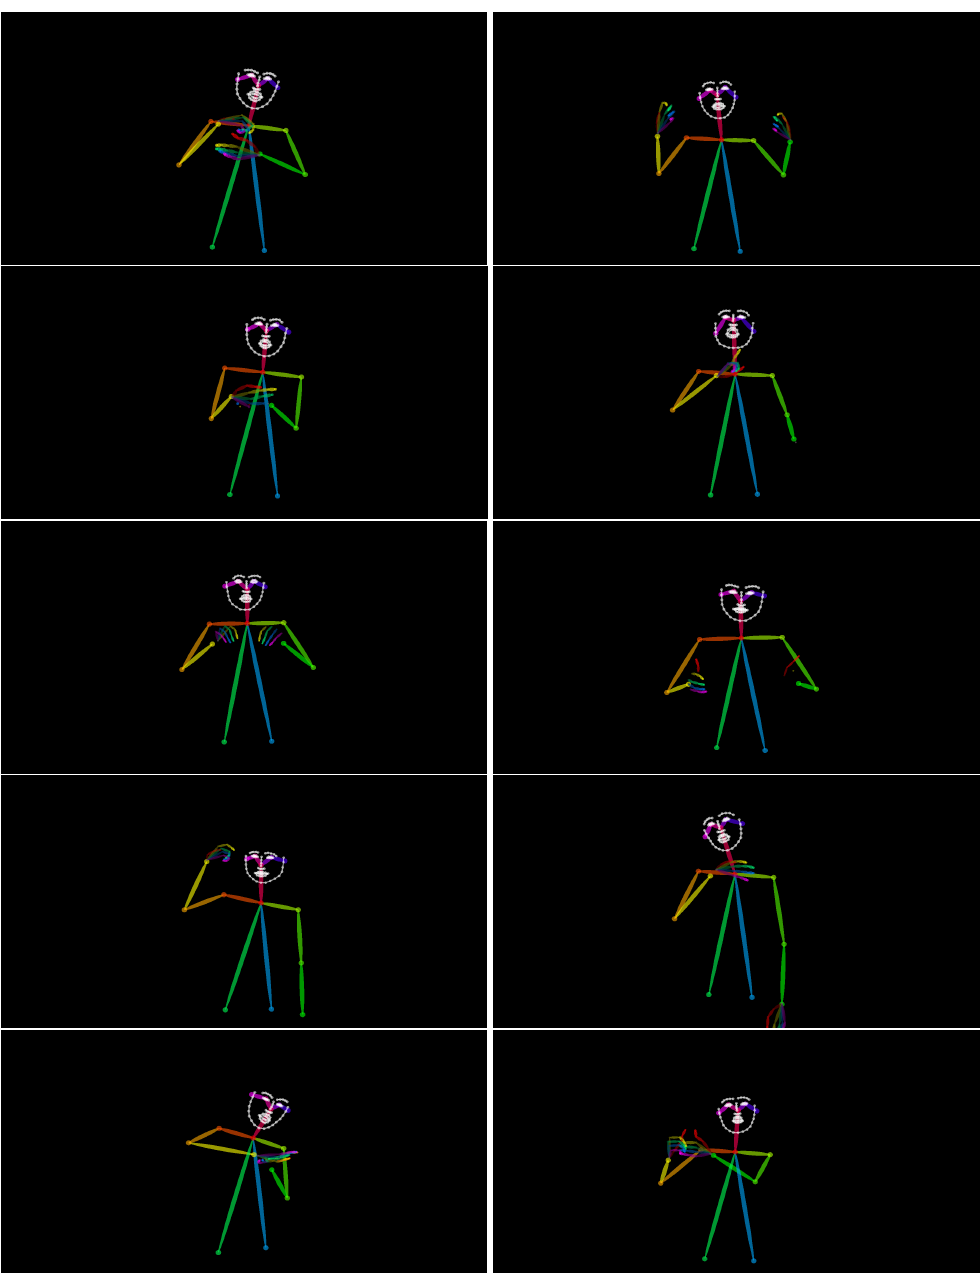
Figure 3. Keypoints extracted from example frames in Figure